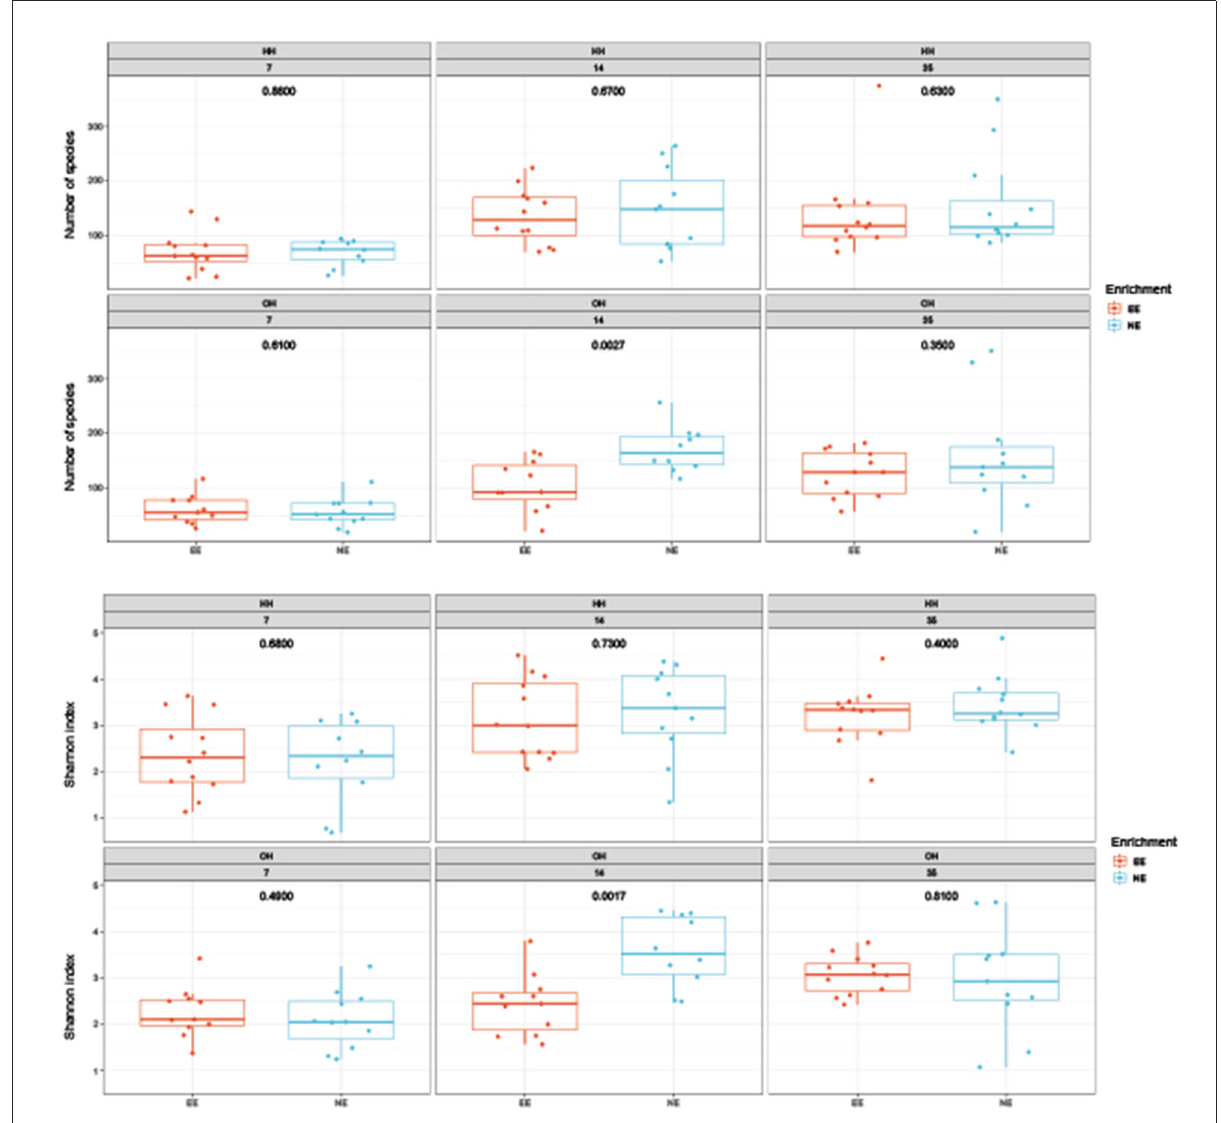
FIGURE4 Diversity of microbiota in jejunal samples on days 7, 14, and 35 of age; observed richness (top boxplot) and the Shannon index (bottom boxplot). P -values of comparison between pens with a dark brooder (EE) and without a brooder (NE) within the hatchery-hatched (HH) respectively, on-farm hatched treatments (OH) for each age are indicated in the boxplots. Each point represents a